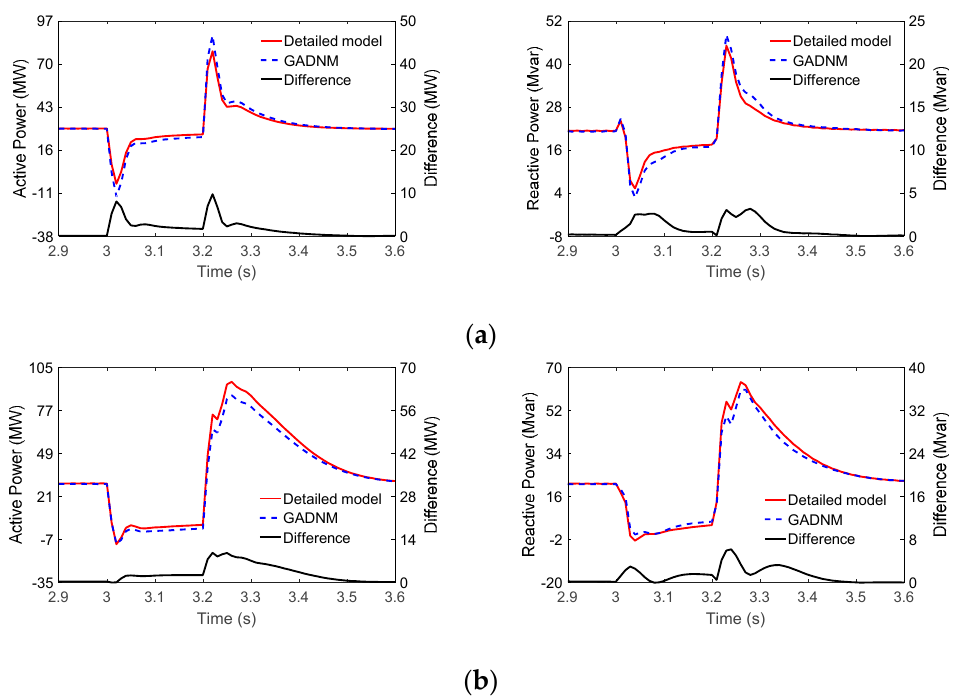
= 50%. ( a ) 20% U n voltage dip.